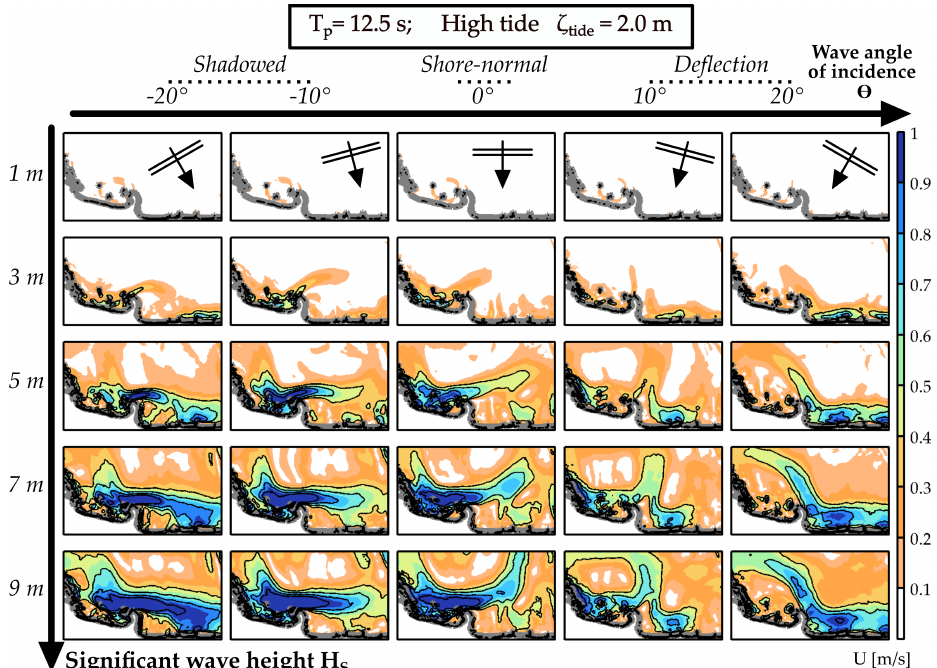
Figure 11. Modelled mean velocity field under various offshore significant wave height H s and wave angle of incidence θ at high tide ( ζ tide = 2.0 m). Black lines indicate the 0.4, 0.6, 0.8 and 1.0 m/s contours. The grey line shows the mean sea level